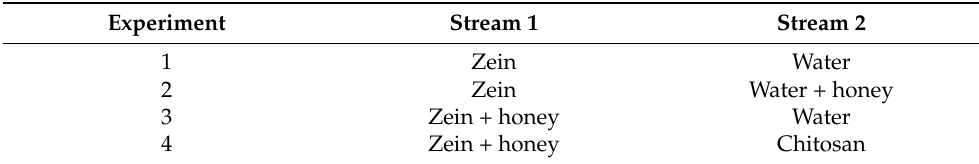
Table 1. Experiments performed in this work with different alternatives in solutions used in stream 1 and stream 2.